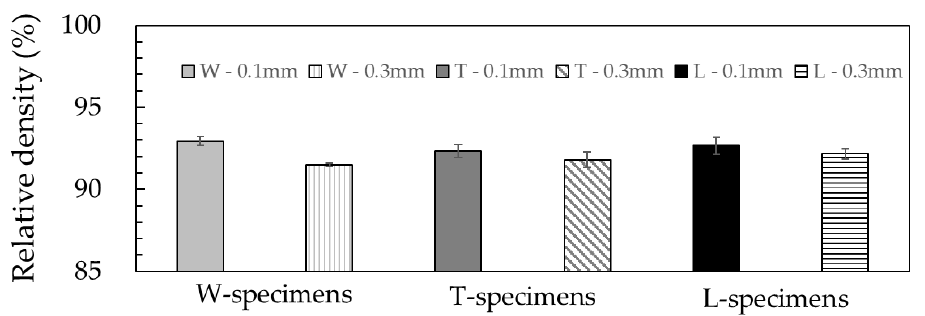
Figure 3. Results of relative density measurement of green parts printed in various layer directions and thicknesses.